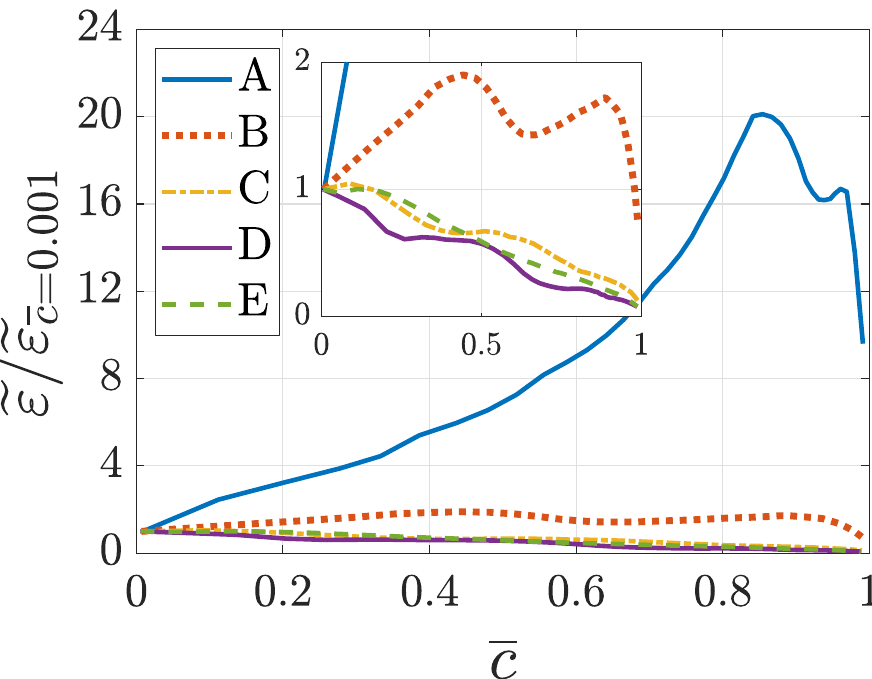
Figure 6. Variations of normalised ε normalised by its value at c = 0.001 with c for cases A–E. Figure 6: The turbulent kinetic energy dissipation normalised by its value at c = 0 . 001 against Reynolds (cid:101) averaged combustion progress variable c